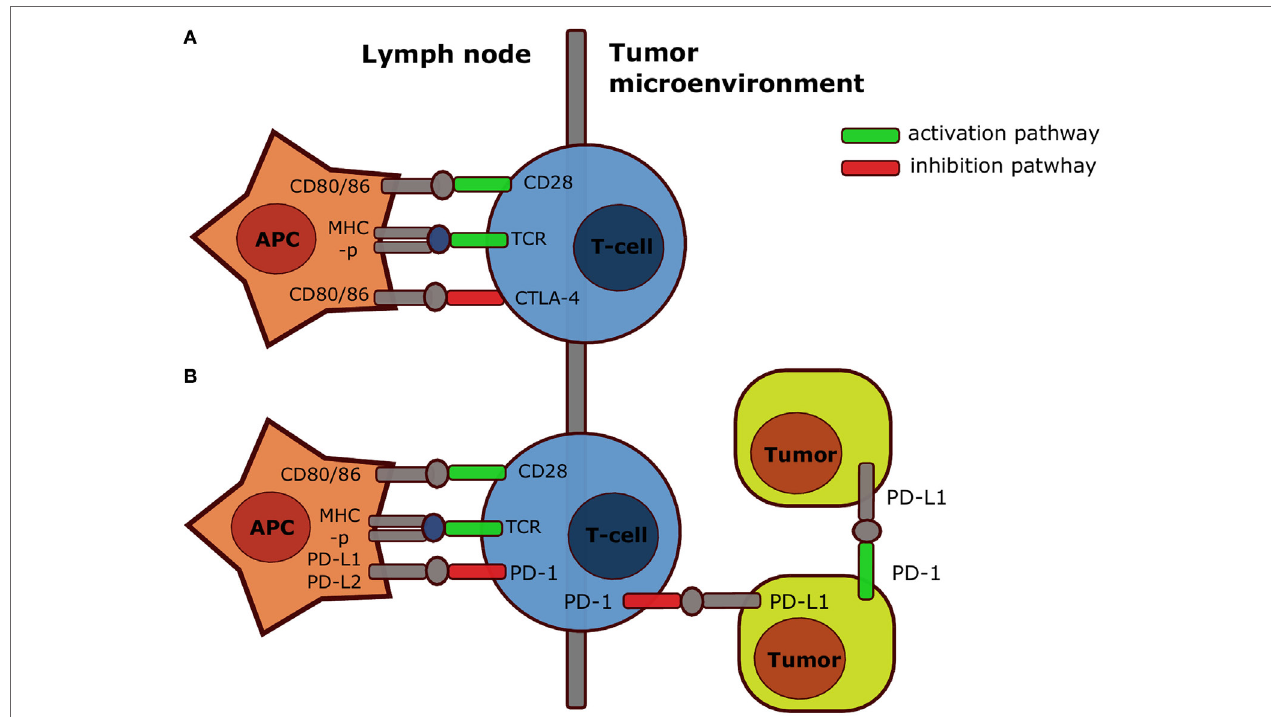
FigURe 2 | Simplified mechanism of action CTLA-4 and PD-1 . Both CTLA-4 (A) and PD-1 (B) inhibit T cell activation in secondary organs after interaction with respectively B7 or PD-L1 and PD-L2. However, PD-1 also inhibits T cell responses after interaction with PD-L1 on tumor cells, and PD-1 expressed by a specific subset of tumor cells also contributes directly to tumorigenesis upon interaction with PD-L1 on tumor cells or stroma cells. Abbreviations: APC, antigen-presenting cell; CD, cluster of differentiation; CTLA-4, cytotoxic T lymphocyte antigen-4; MHC-p, peptide-major-histocompatibility complex; PD-1, programed death-1; PD-L1, programed death-ligand-1; TCR, T cell receptor. Note that the scheme is highly simplified: in reality CTLA-4 and PD-1 act through multiple